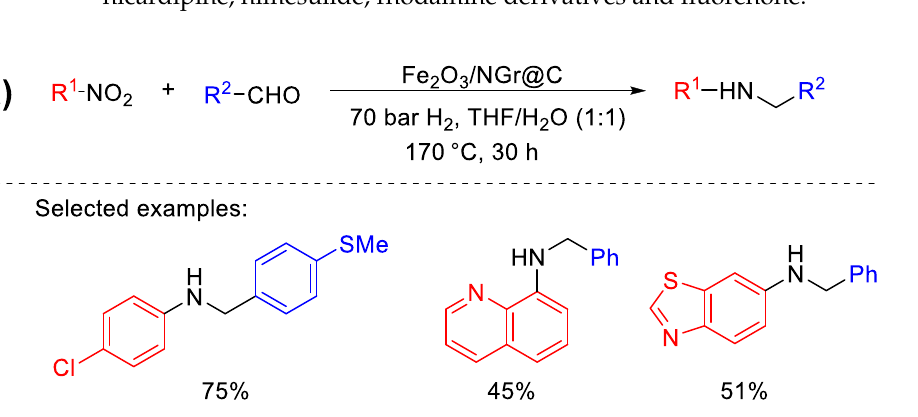
Figure 14. Schematic diagram of the preparation of N, S-codoped Fe 20 -SA@NSC and its catalytic application for synthesizing N -alkylation of aromatic amines under solvent-free conditions. Reprinted with permission from Ref. [66]. Copyright 2021, Royal Society of Chemistry.